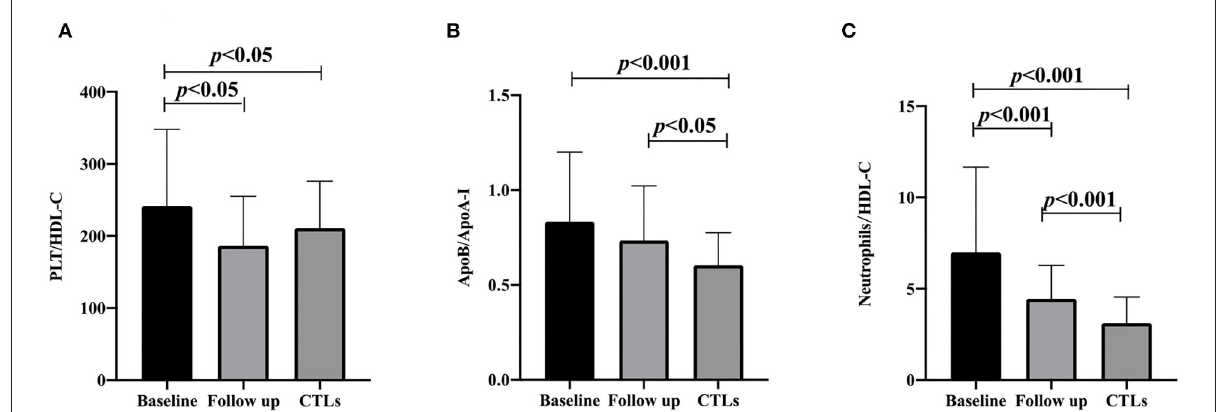
FIGURE1 PLT/HDL-C ratio, ApoB/ApoA-I ratio, and neutrophils/HDL-C ratio are compared with CTLs at the baseline and follow-up of anti-NMDAR encephalitis. (A) PLT/HDL-C ratio; (B) ApoB/ApoA-I ratio; (C) neutrophils/HDL-C ratio. A one-way analysis of variance (ANOVA) was used for multiple comparisons, following by the least significant difference (LSD) and Tamhane T2(M) were performed for post-hoc test. A two-sided p -value of < 0.05 was defined statistically significant. CTLs, controls; PLT, platelet; HDL-C, high-density lipoprotein cholesterol; ApoA-I, apolipoprotein A-I; ApoB, apolipoprotein B100.